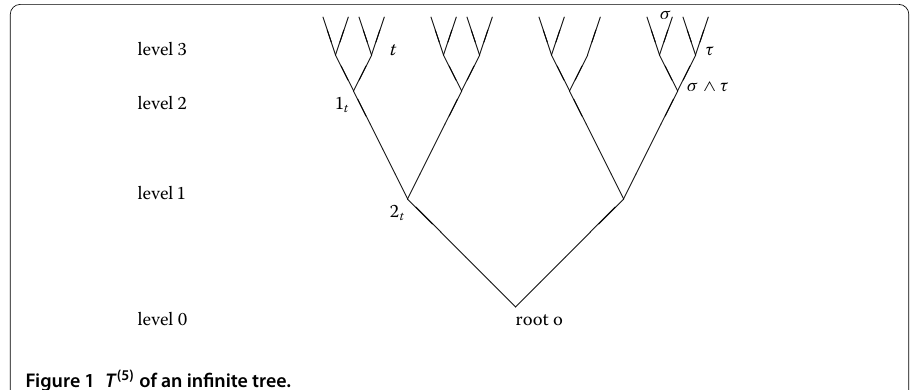
Figure 1 T (5) of an infinite